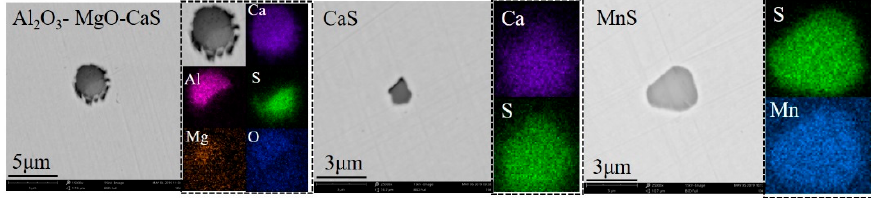
Figure 5. SEM images and energy-dispersive spectroscopy (EDS) maps of the typical inclusions in B2.